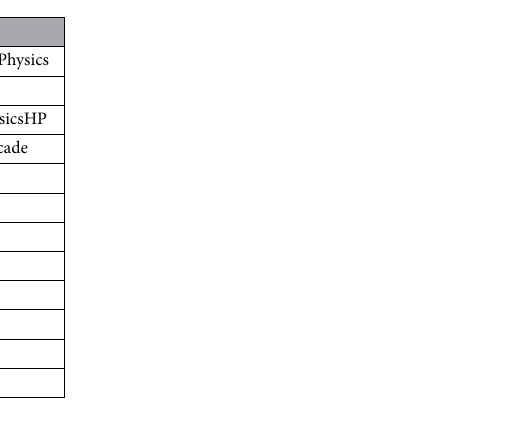
Table 1. Physics models used in all